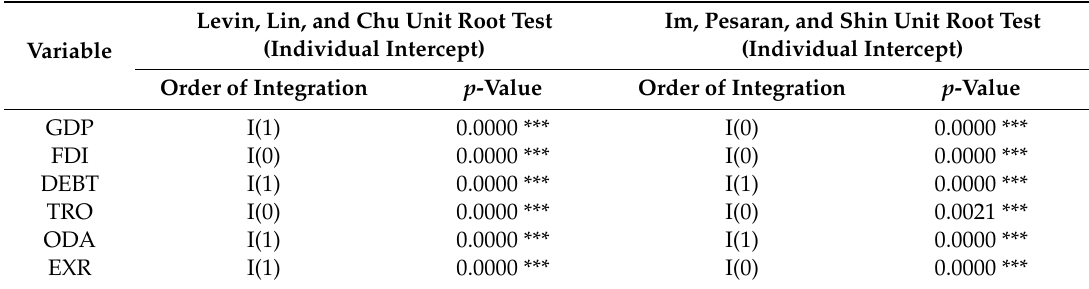
Table 4. LLC and IPS panel unit root tests for high-income.